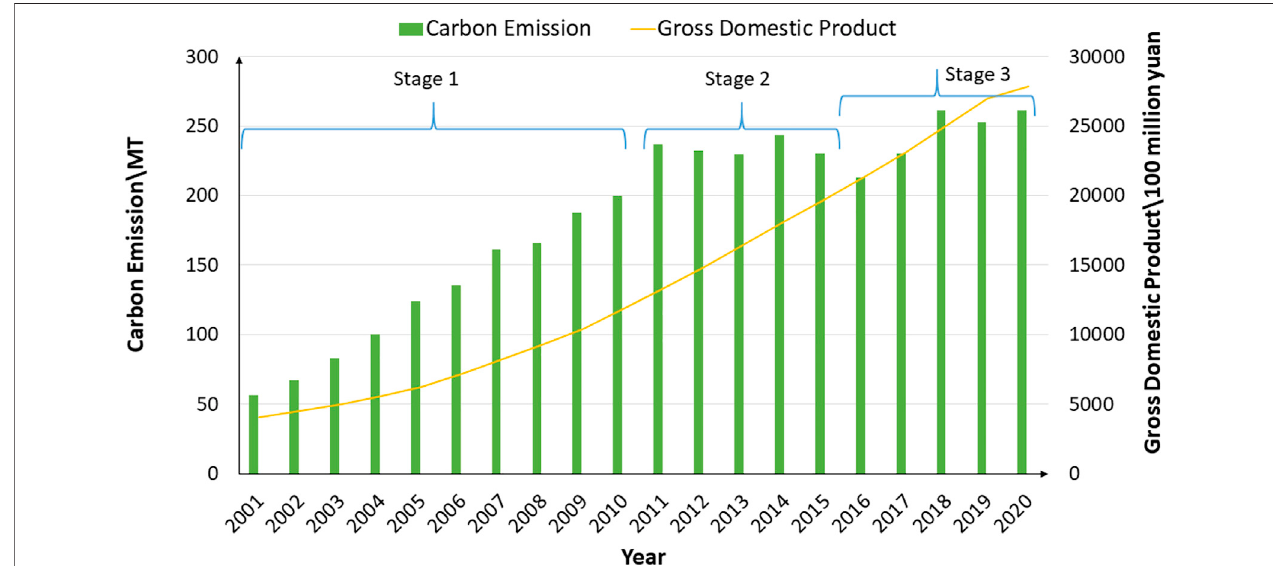
FIGURE 1 | The trend of Carbon Emissions and GDP of Fujian Province from 2001 to 2020.